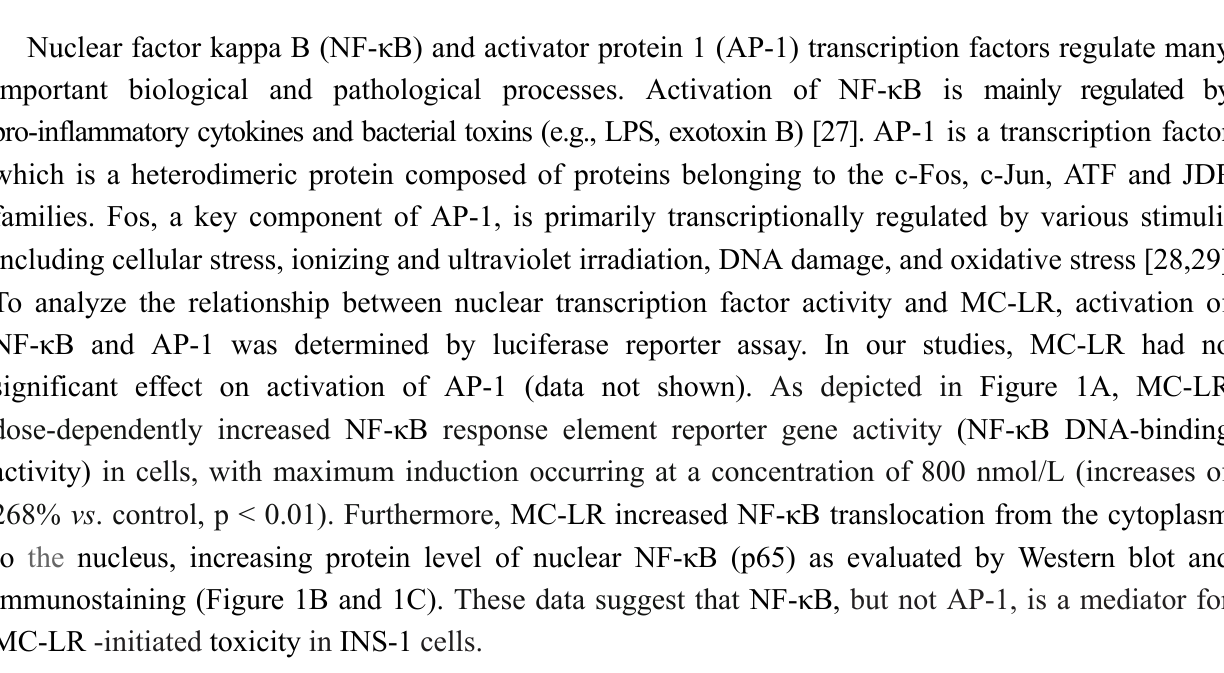
( A ) MC-LR dose-dependently increased NF- κB activation in luciferase reporter assay. vs . control (DMSO); # p < 0.05, ## p < 0.01 vs . group at the same dose of MC-LR without PDTC; ( B ) Protein level of the p65 subunit of NF- κB, as determined by Western blot ; ( C ) Representative immunofluorescence localization for p65 subunit. MC-LR